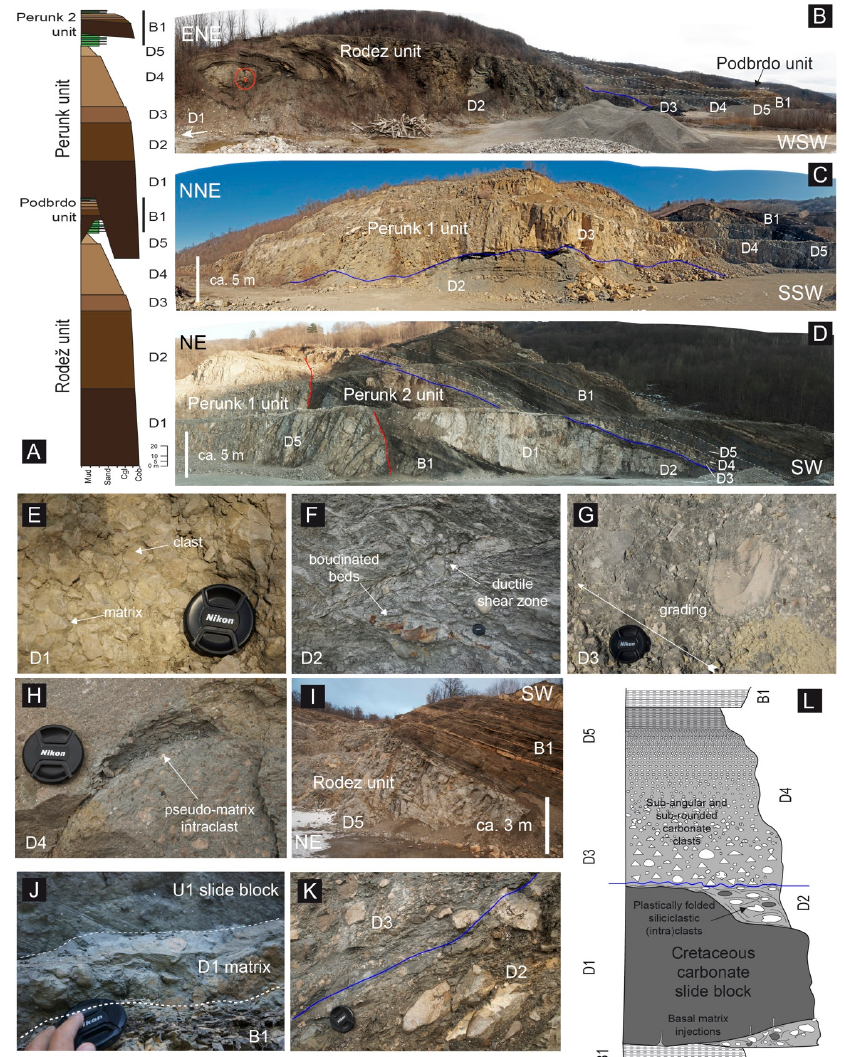
Figure 2. Field appearance of the studied megabeds and their constituting (sub)divisions. ( A ). Simplified stratigraphic column illustrating the investigated megabeds and their internal subdivision, with location of the samples used for geochemical analyses. ( B ). Rodez unit (circled person for scale) and Podbrdo unit in the background. ( C ). Perunk 1 unit. ( D ). Perunk 2 unit. ( E ). Close-up view of D1 marly matrix (Rodez unit). ( F ). Soft-sediment deformation structures in the marly calcareous matrix of D2 (Rodez unit). ( G ). Overview of the calcareous breccia of D3 (Rodez unit). ( H ). Basal calciruditic horizon grading upwards into calcarenites (Rodez unit). ( I ). Sharp contact between laminated marlstones, and background succession B1, which includes minor megabeds (Rodez unit). ( J ). Closeup view of the matrix of the Unit 1, containing a folded and contorted intraclast of the background succession (B1), below, and showing the erosive base of the isolated carbonate slide block of the Perunk 2 unit (upper Cretaceous carbonate-platform outrunner slide block). ( K ). Contact between two lithologically different carbonate (upper—D3) and marly (lower—D2) matrix. ( L ). Schematic lithostratigraphic log of the Perunk 2